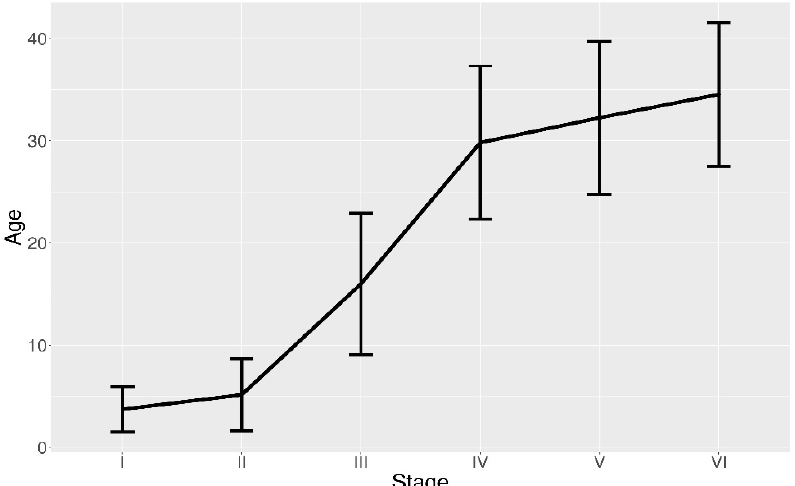
Figure 7. Average age (i.e., number of hours) and relative confidence interval of each postovulatory follicle (POF) stage (I to VI), measured by time between spawning time peak and time of capture. Stage I only occurred at certain times of the night close to the ASP, around 22:00 (local